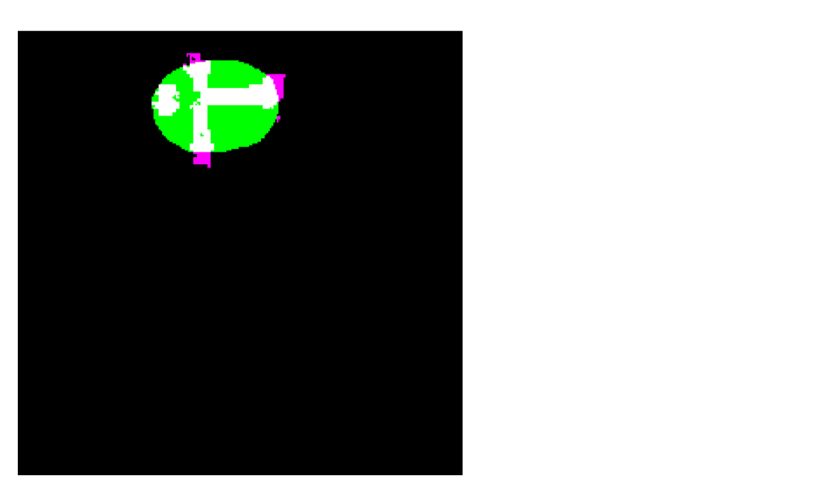
Figure 13. AUC value plot for images used on CNN. 5. Conclusions Breast cancer is one of the leading causes of death among women worldwide. Early detection helps reduce the number of premature deaths. This study uses medical ultra- sound scans to examine medical images of breast cancer. Breast ultrasound datasets are classified into three classes: normal, benign, and malignant. When combined with ML, breast ultrasound images can have great results in classifying, diagnosing, and classifying